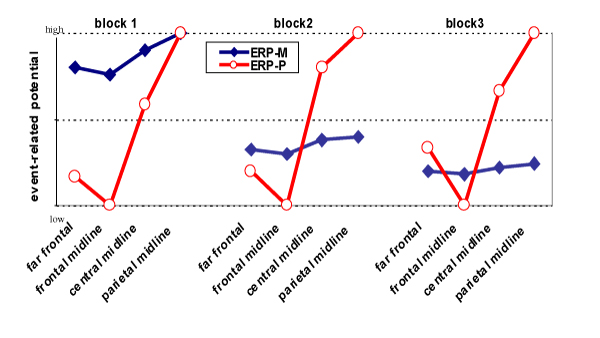
An example of magnitude and pattern of multidimensional ERP measures for combining to univariate phenotypes. ERP measures are projected as profiles. Measures within a block (block 1: late time window – 3–7 Hz wave band, block 2: late time window – 1–2.5 Hz wave band, block 3: early time window – 3–7 Hz wave band) are connected. Within each block measures are taken at different locations on the skull. The dotted line represents the mean of all measures. Blue, ERP-M taking into account structure + magnitude: measures of block 1 are much larger than eothers (block 2 and 3), independent from location on the skull. Red, ERP-P taking into account structure: measures of the central and parietal midline channel are larger than those of the frontal channels, this pattern is congruent across blocks.